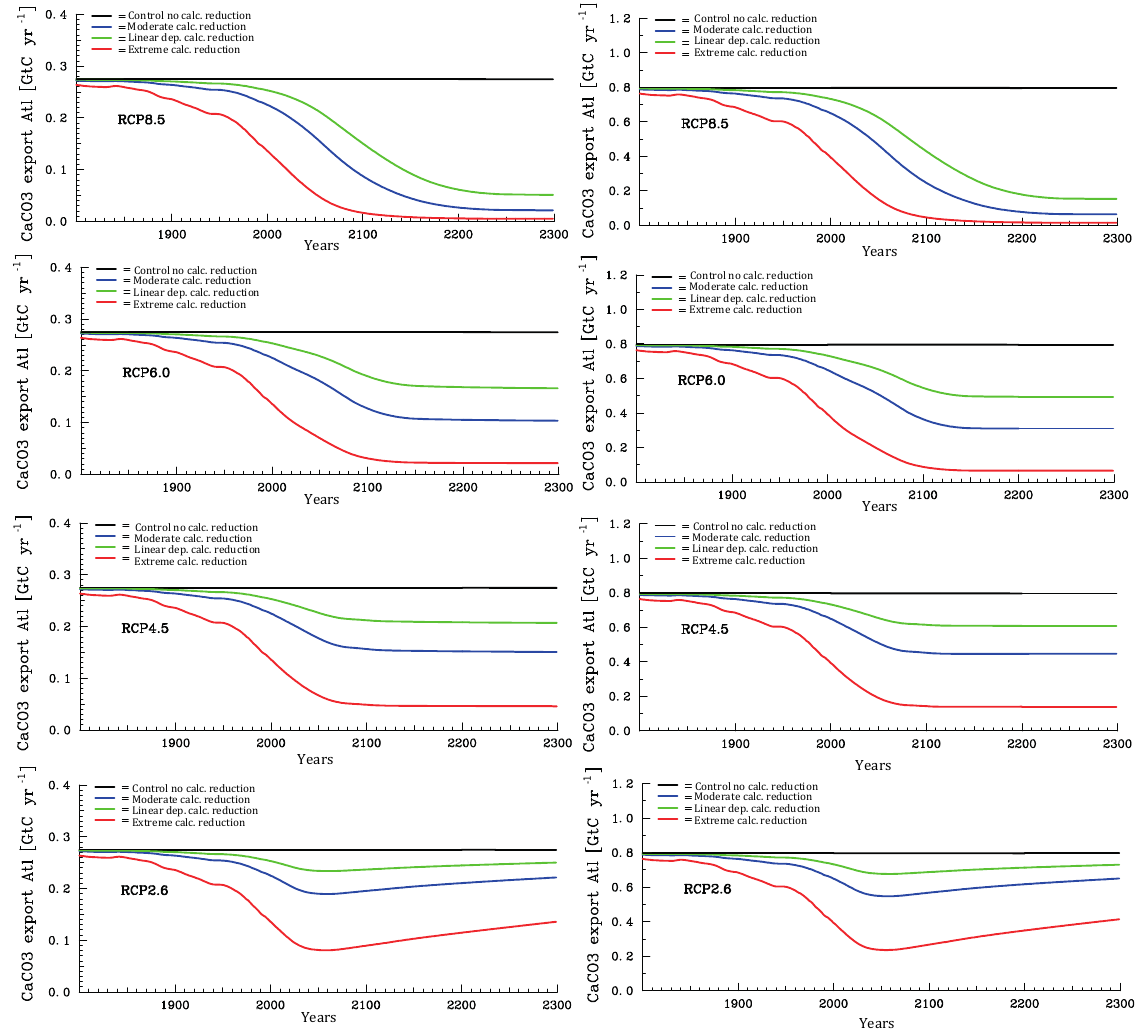
Figure 8. Temporal evolution of Atlantic (left column panels) and Pacific (right column panels) annual mean CaCO 3 export production under the different scenarios for the sensitivity of calcification under high CO 2 (unit: GtCyr − 1 ). From top to bottom for greenhouse gas scenarios RCP8.5, RCP6.0, RCP4.5, and